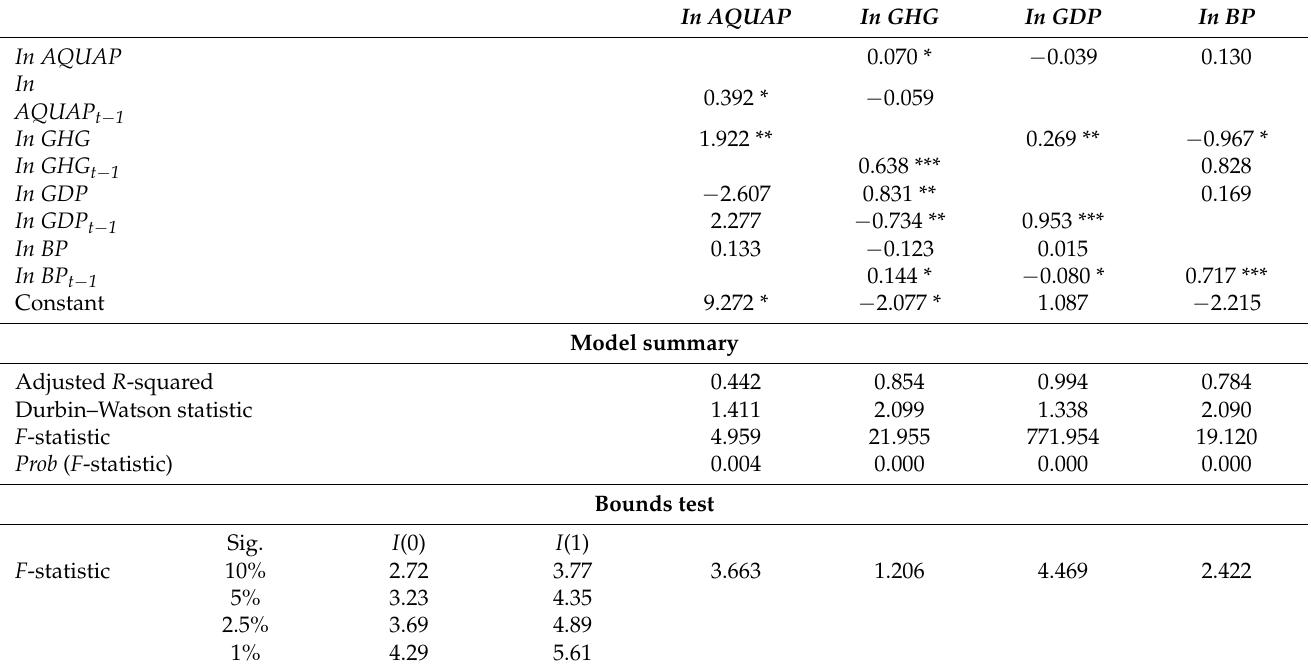
Table 3. ARDL Bounds